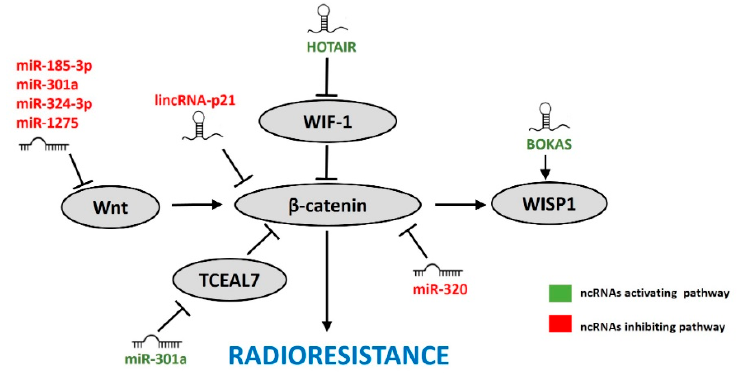
Figure 6. ncRNAs involved in the IR-induced Wnt / β -catenin pathway. ncRNAs promoting (green) or inhibiting (red) the Wnt / β -catenin pathway-induced radioresistance.